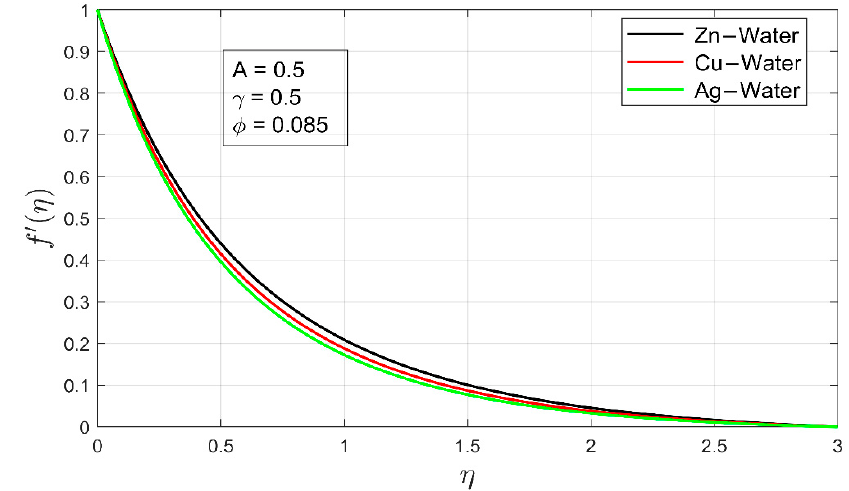
Figure 2. Comparison of velocity profiles f (cid:48) ( η ) for different nanofluid.